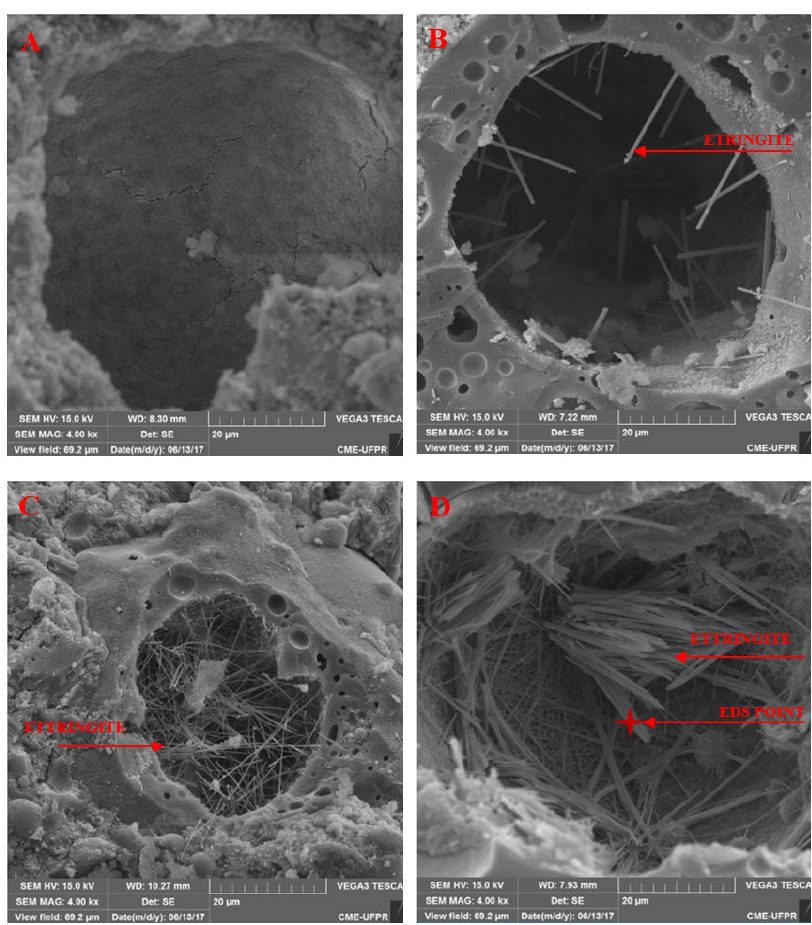
Figure 6. Comparative analysis of pore evolution for the series studied (A - 0.0%, B - 0.5%, C - 1.0% and D - 5.0% SO 3 ) at 360 days of age.